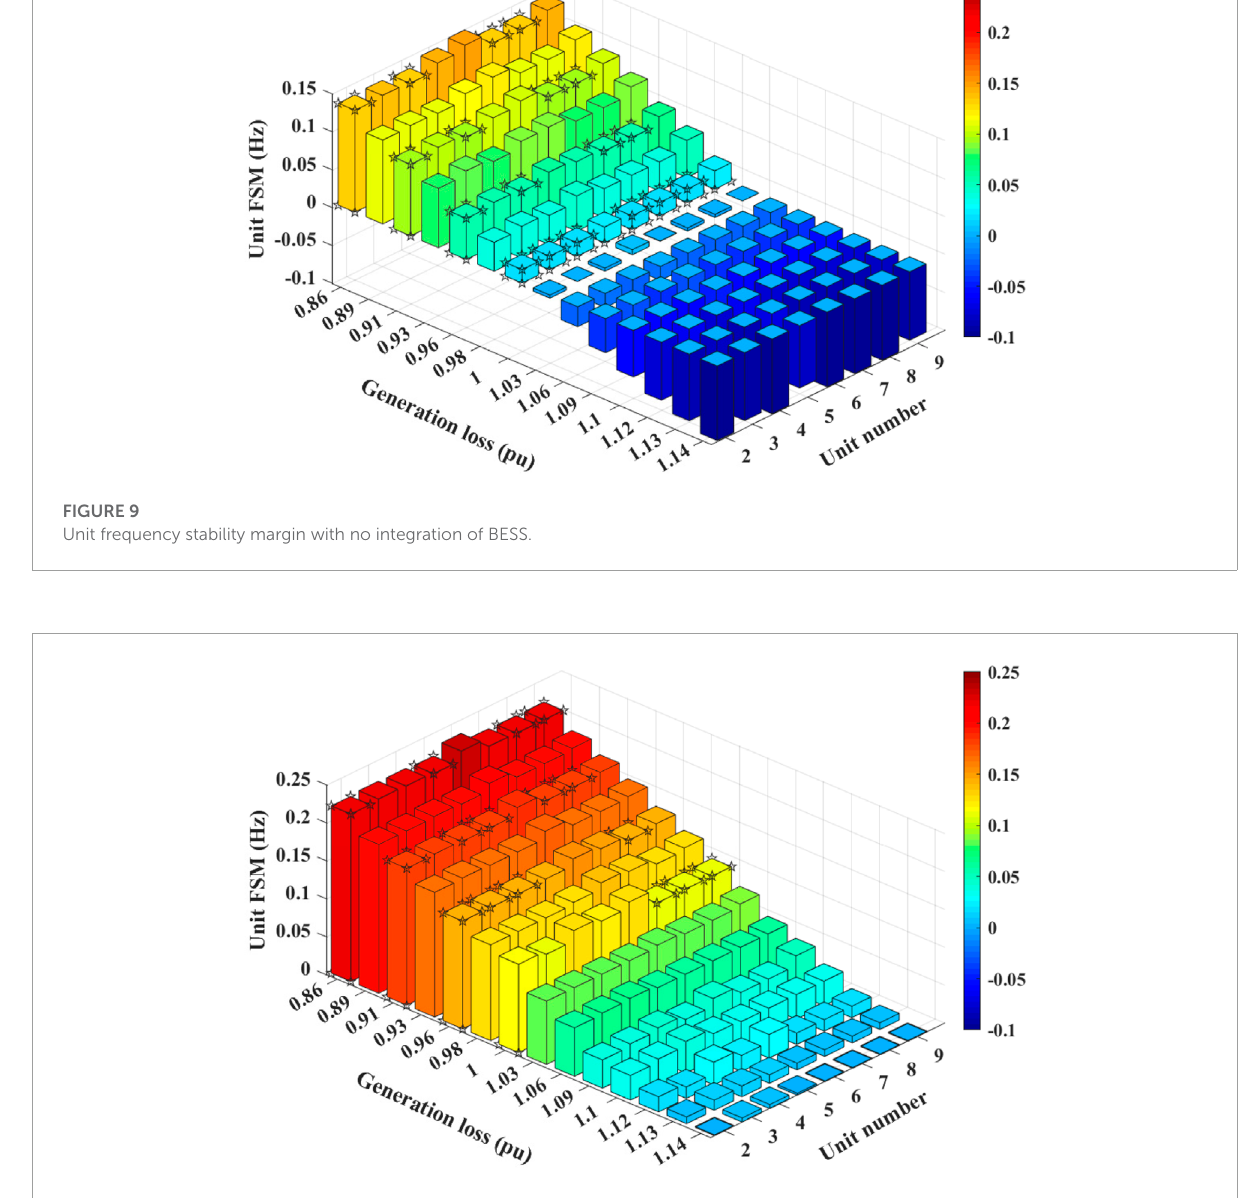
easily come into being sudden increase. Figure 7C privides the changes of BESS discharge power (DP) with time. It is seen that BESS begins to discharge power immediately after the disturbanceandprovidesfrequencysupportthroughoutprimary frequency regulation. Note that BESS does not keep discharging power without interruption, for the total electromagnetic power include sudden increase. Moreover, only a small amount of BESS energy is needed to participate in frequency